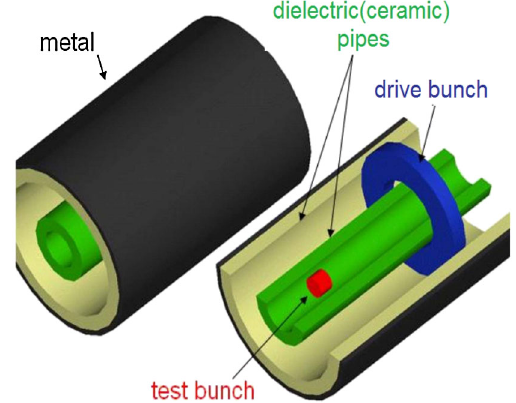
FIG. 1. Schematic of the CDWA structure, showing a single annular drive bunch followed by an accelerated witness bunch that moves along the